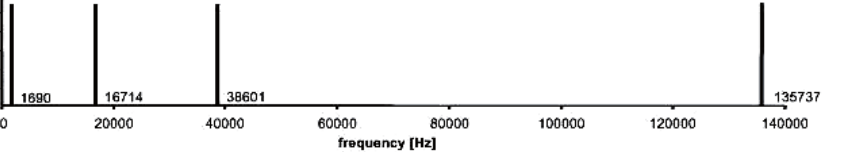
Fig. 9. Cantilever loaded by a mirror attached at point B .